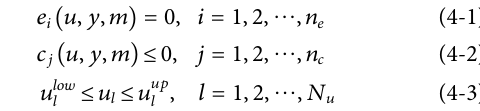
Figure 1 , and the inversion results of characteristic parameters are shown in Figure 2 .